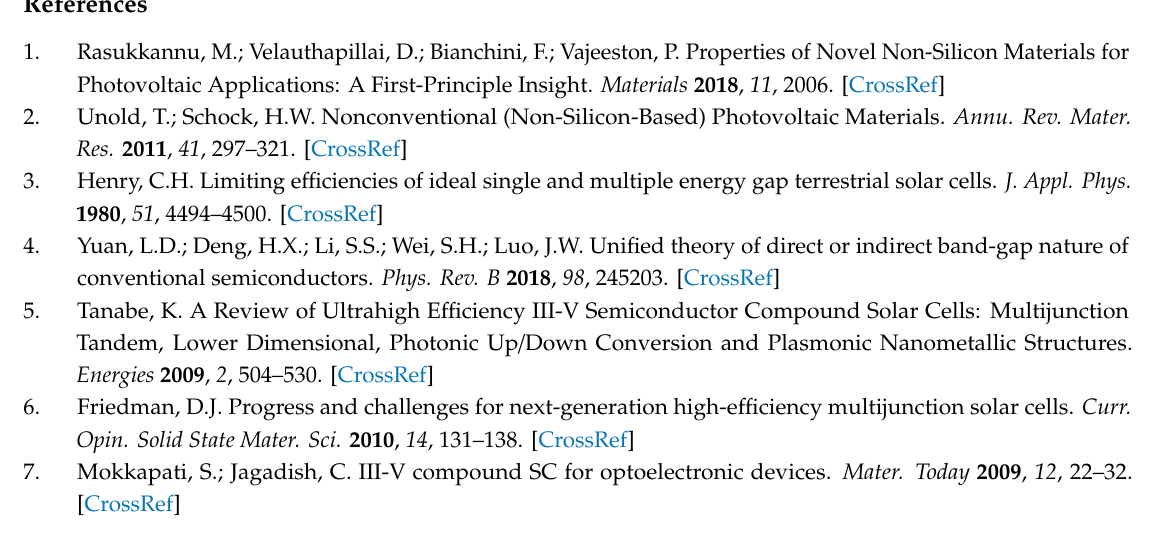
Figure S1: Calculated bandgap at Γ -point for InP by using PBE + U formalism ( U e ff = 5, 8, 10, 15, 18 eV). The crystal structure optimizations were performed using the PBEsol. The blue and green dotted lines stand for G 0 W 0 and experimental value; Figure S2: Electronic band structure (left) and the density of states (right) of InP were calculated with the G 0 W 0 approach, along with the main energy di ff erences at Γ -point. The zero energy was set to the Fermi level (the black dotted line). The spin-up and spin-down bands and DOS are not given separately, as both contributions are the same for the native InP material; Figure S3: Electronic band structure of TM@InP (TM = Ti, V, Cr, Mn) calculated with the G 0 W 0 approach, along with the main energy di ff erences at Γ -point. The zero energy was set at the Fermi level (black dotted line); Figure S4: Density of states of TM@InP (TM = Ti, V, Cr, Mn) calculated with the G 0 W 0 approach. The zero energy was set at the Fermi level (the black dotted line); Table S1: Crystal Structure of TM (TM = Ti, V, Cr, Mn), In and P